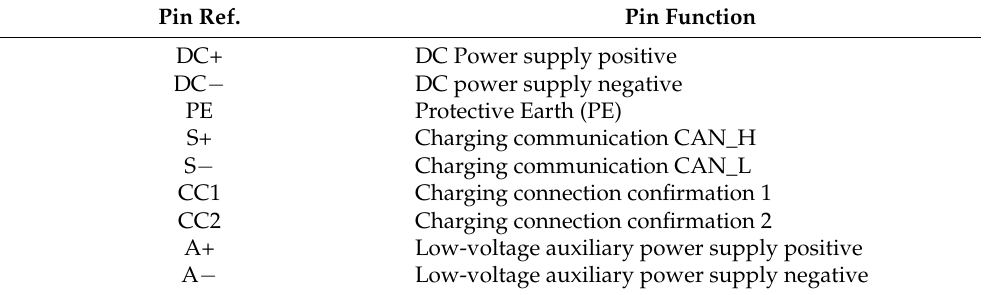
Table 10. GB/T 20234 DC Coupler pins functions.